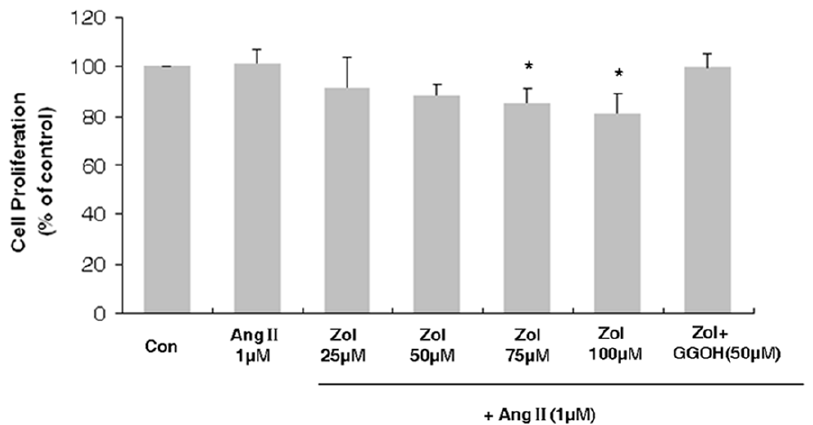
Figure 2. Proliferation of EPCs in response to Ang II and Zol. EPC proliferation was not affected by Ang II, and decreased in presence of Zol and could be partly reversed by GGOH. Data are presented as mean 6 SD, n=5. * P , 0.05 vs. Ang II group.